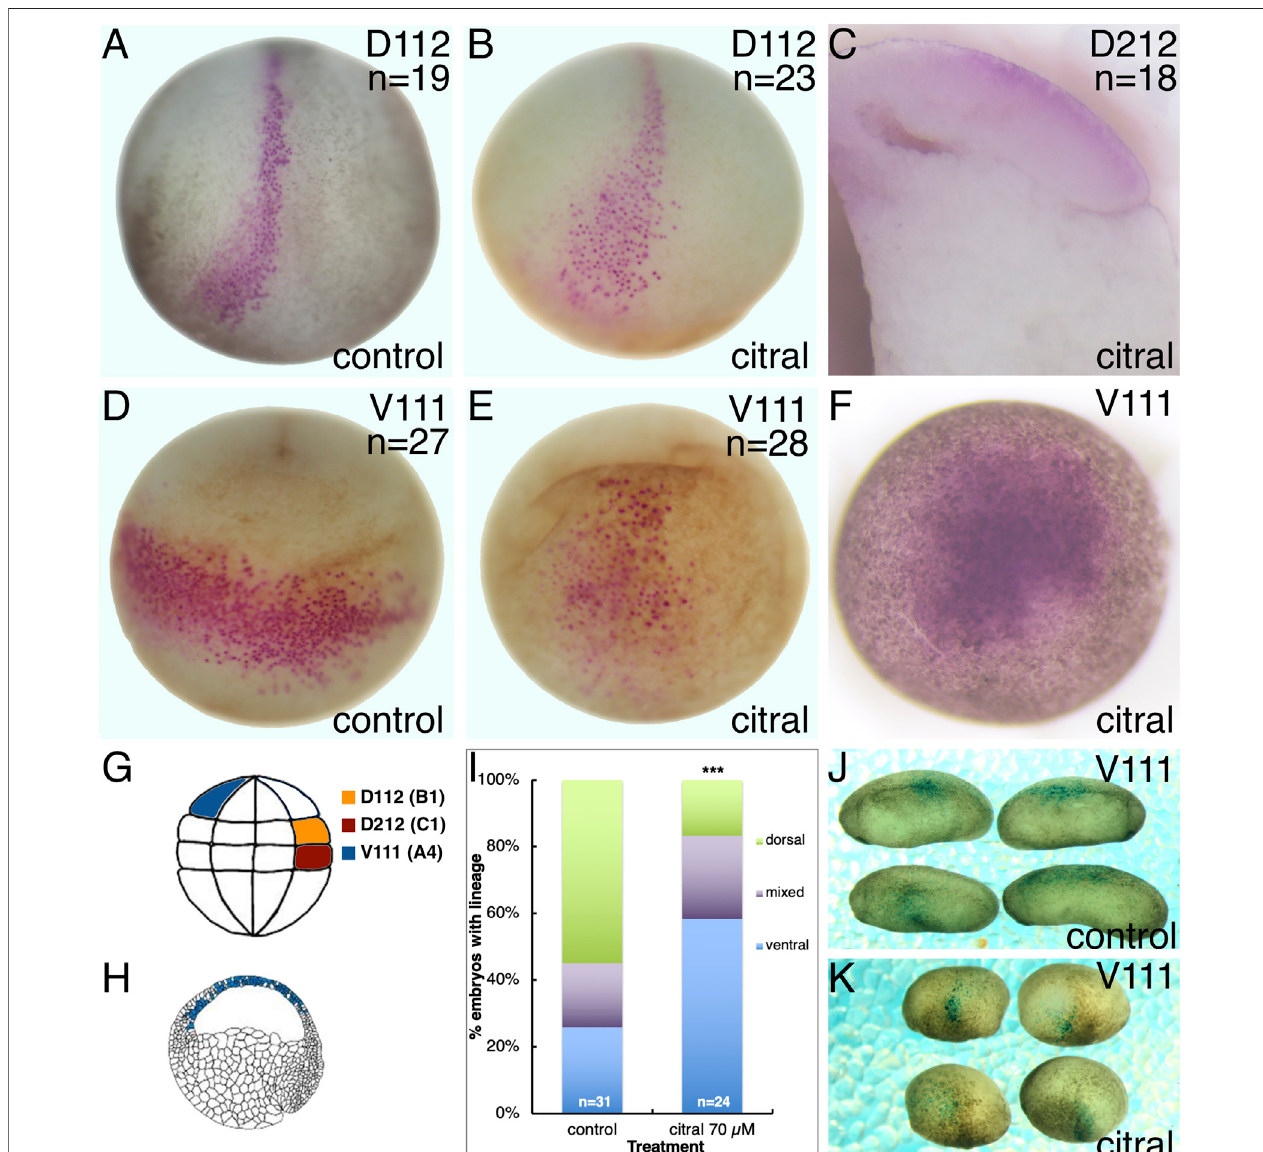
FIGURE 5 | Reduced RA signaling does not alter the dorsal-ventral axis. Single 32-cell blastomeres were injected with lineage tracer mRNA and labeled clones mapped at different developmental stages. (A,B) At stage 15, the D112/B1 clone (pink cells) occupies the medial and anterior neural plate in both untreated control (A) and citral treated (B) embryos. Dorso-anterior views. (C) The D212/C1 blastomere that normally contributes to the involuting dorsal mesoderm at gastrulation (st 10.5; Bauer et al., 1984) also does so in citral-treated embryos. Mid-sagittal section with anterior to the left and dorsal to the top. (D) At stage 17, the V111/A4 clone in untreated control embryos forms a coherent ventrolateral clone. Ventral view with anterior to the top. (E) In citral-treated sibling embryos, the stage 17 V111/A4 clone remains medial,i.e.,hasnotexpandedlaterally, andthecellsaremoredispersed.Ventralviewwithanteriortothetop. (F) Atgastrulastages(st10.5),theV111/A4clone in citral-treated embryos occupies the blastocoel roof, similar to control embryos (cf. H). (G) Location of the 32-cell blastomeres that were lineage traced. Dorsal to the right, animal to the top. (H) Location of the V111/A4 clone (blue cells) at early gastrulation, modi fi ed from Bauer et al. (1984). Animal to the top and dorsal to the right. (I) PercentageofembryosinwhichtheV111/A4clonewaslocatedpredominantlyinthedorsal, ventral, orboth(mixed)epidermisat tailbudstages. (J) Examplesofcontrol embryos showing V111/A4 descendants (blue cells) mostly in the dorsolateral epidermis. Dorsal to the top, anterior to the left. (K) Examples of citral treated embryos showing V111/A4 descendants (blue cells) mostly in the ventral and ventrolateral epidermis. Dorsal to the top, anterior to the left.